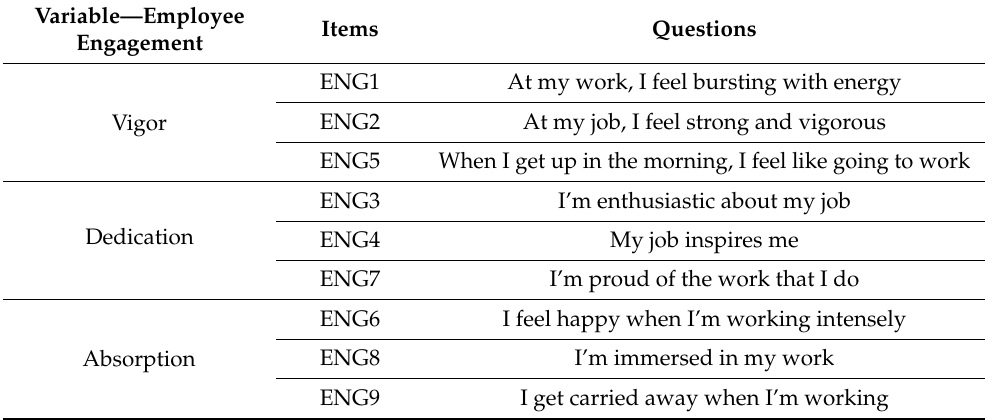
Table 2. Questions about the dependent variable—Employee Engagement (3rd